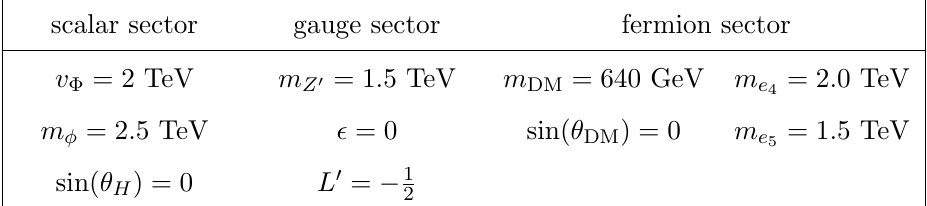
= y 00 and c e = c l ) used (cid:23)=e (cid:23)=e ( m e + m e ) = 2 = 1 : 75 TeV. 4 ’ 4 5